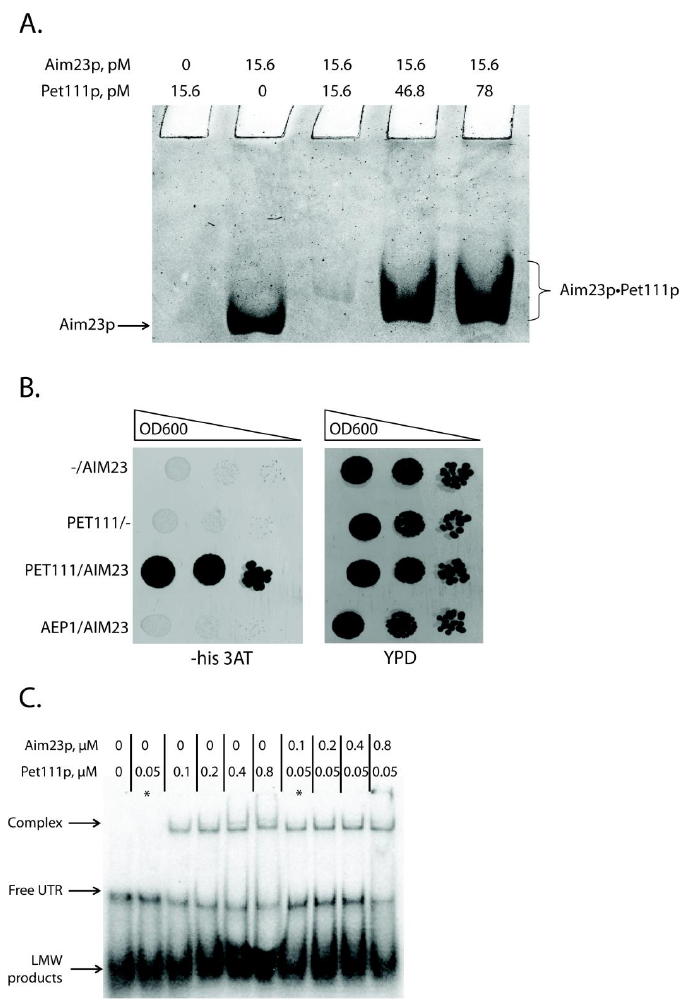
Figure 2. Aim23p physically interacts with Pet111p and helps the latter to bind 5 (cid:48) -UTR of COX2 mRNA. ( A ) Detection of Aim23p interaction with Pet111p in vitro . Recombinant proteins (either one of them or both together) were separated by the native PAGE. The gel zones corresponding to free Aim23p or Aim23p • Pet111p complex are marked on the left and on the right, respectively. The experiment was done in four biological replicates; the characteristic picture is presented. ( B ) Results of the two-hybrid system assay. Four derivatives of the Y190 yeast strain were analyzed, transformed by: (1) empty pAS2 ∆∆ vector and pACT2-AIM23 plasmid ( − / AIM23), (2) pAS2 ∆∆ -PET111 plasmid and empty PACT2 vector (PET111 / − ), (3) pAS2 ∆∆ -PET111 plasmid and pACT2-AIM23 plasmid (PET111 / AIM23), (4) pAS2 ∆∆ -AEP1 plasmid and pACT2-AIM23 plasmid (AEP1 / AIM23). The names of the strains are depicted on the left. Left panel: growth on medium lacking histidine supplemented with the 3-amino-1,2,4-triazole (3-AT). Right panel: growth on the rich glucose-containing medium (YPD). The ten-fold consecutive dilutions of the yeast suspensions were plated. The experiment was done in three biological replicates; the characteristic picture is presented. ( C ) The results of the gel-shift experiment. In vitro synthesized COX2 mRNA 5 (cid:48) -UTR was labeled with 32 P-ATP and then incubated with di ff erent amounts of the recombinant Aim23p and / or Pet1119 (molar concentrations of the proteins are indicated on the top). Reaction products were separated using native PAGE and visualized by radioautography. The gel zones corresponding to low molecular weight (LMW) products, free UTR and UTR complex with Pet111p are marked by the arrows on the left. The asterisks mark two characteristic reactions where Pet111p concentration was equal, and one reaction contained Aim23p (complex detected) and another did not (complex not detected). The experiment was done in four biological replicates; the characteristic picture is